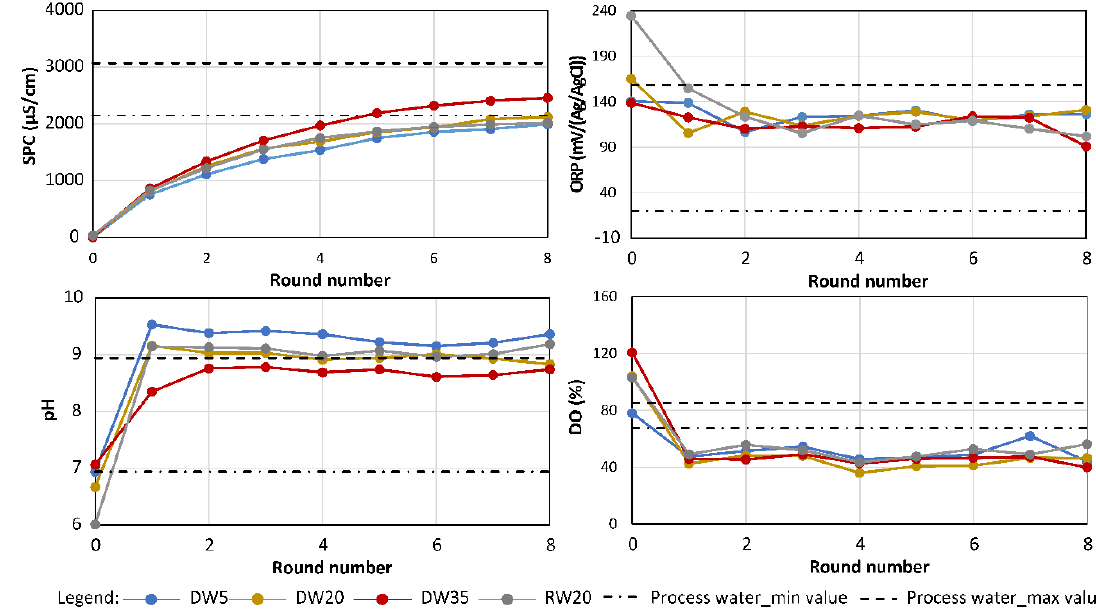
Figure 3. SPC, ORP, pH, and DO measurements for different water types as a function of dissolution round number.